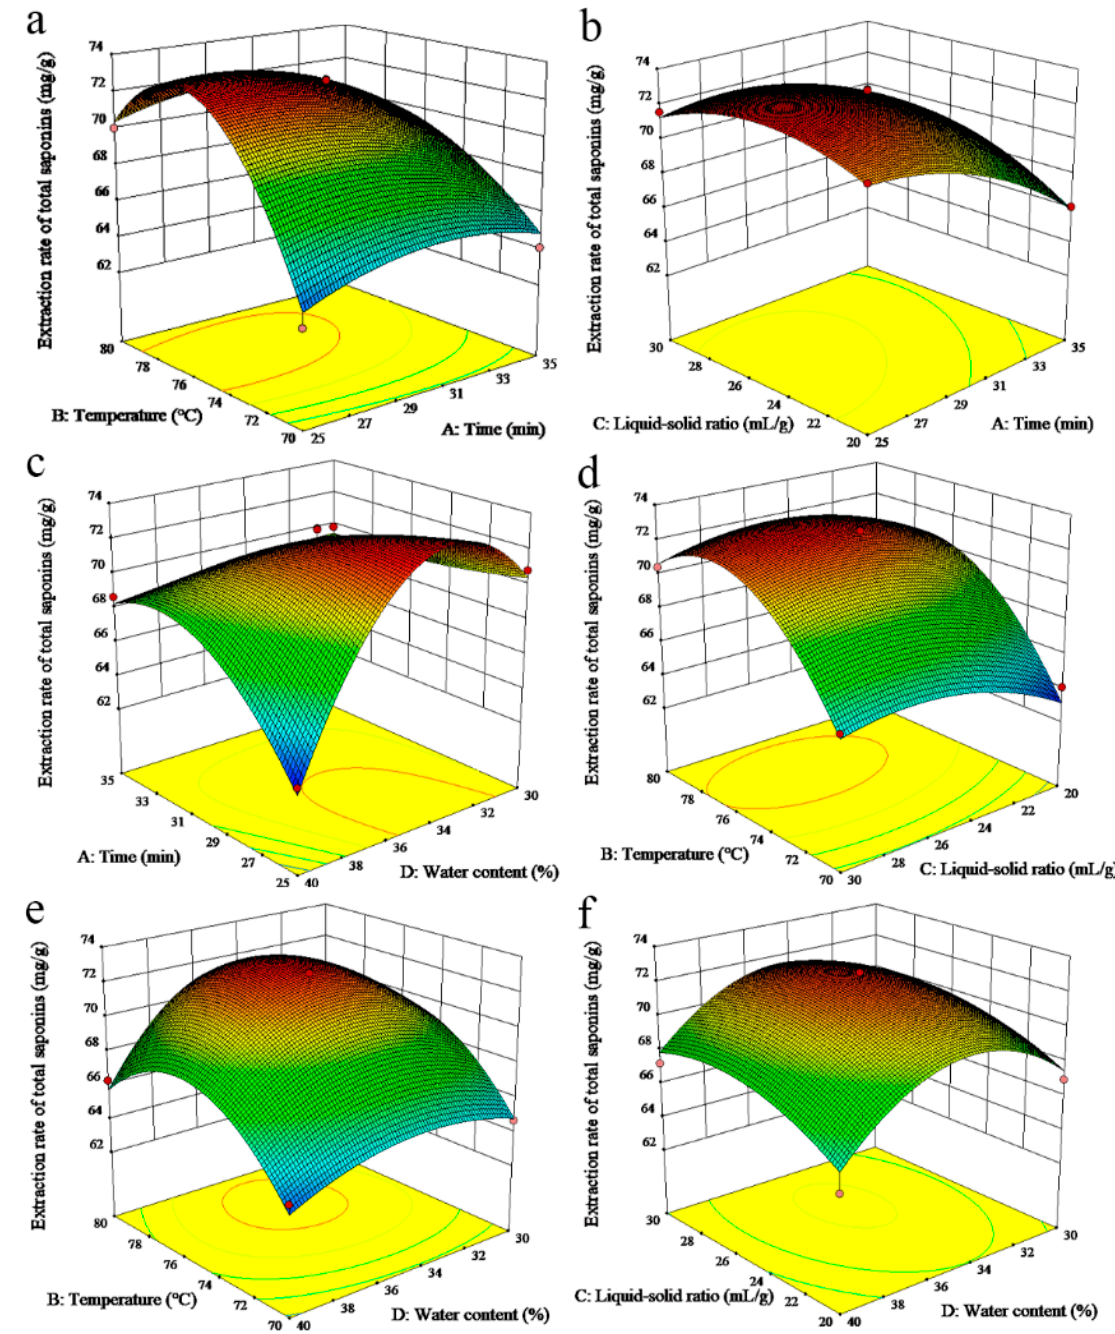
Figure 3. Comprehensive score of the response surface of the total saponins extraction rate. ( a ) The interaction between extraction time and temperature; ( b ) the interaction between liquid–solid ratio and extraction time; ( c ) the interaction between extraction time and water content; ( d ) the interaction between liquid–solid ratio and extraction temperature; ( e ) the interaction between water content and extraction temperature; ( f ) the interaction between water content and liquid–solid ratio.